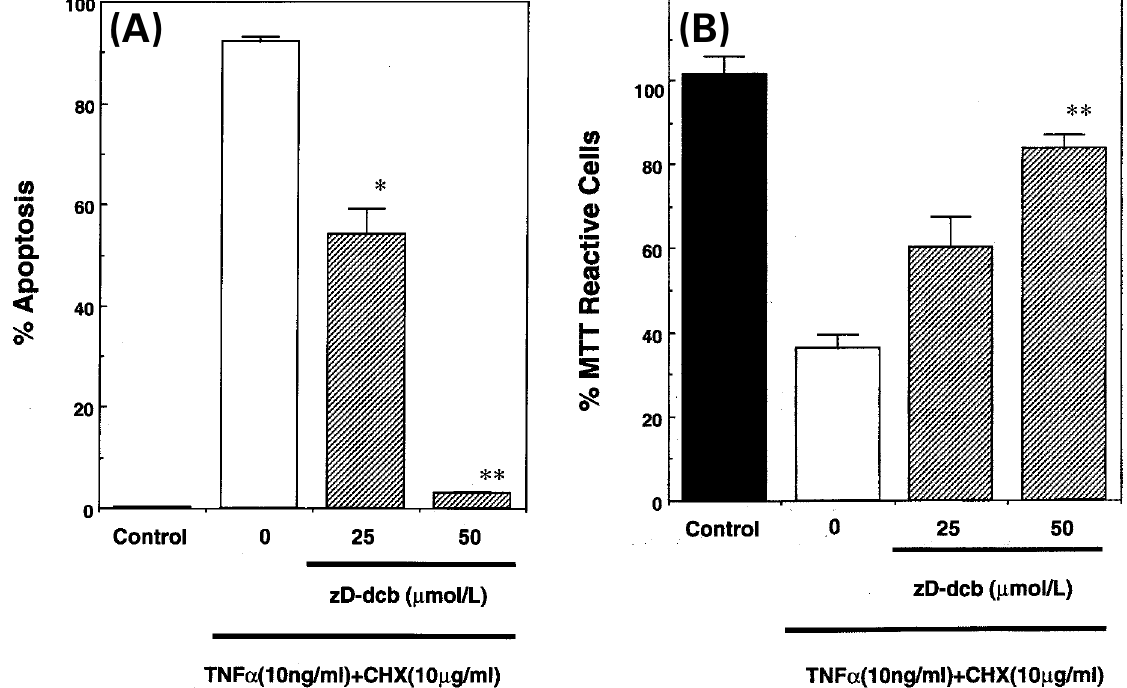
FIG. 4. Effect of an inhibitor of caspase on TNF a and cycloheximide-induced apoptosis of endothelial cells. (A) Endothelial cell monolayers were treated with TNF a (10ng/ml) and cycloheximide (10 m g/ml) in the presence of various concentration of zD- dcb, an inhibitor of ICE (0–50 m mol/l), for 6h. After the incubation treatment, the cells were stained with PI, as described in Materials and methods. * P <0.05 versus TNF a and cycloheximide-treated group; ** P <0.01 versus TNF a and cycloheximide- treated group. Each experiment was repeated three times. (B) Endothelial cell monolayers were treated with TNF a (10ng/ml) and cycloheximide (10 m g/ml) in the presence of various concentration of zD-dcb, an inhibitor of caspase (0–50 m mol/l), for 6h. After the incubation treatment, the cells were stained with MTT, as described in Materials and methods. The data show the mean±SEM for eight wells. ** P <0.01 versus TNF a and cycloheximide-treated group. Each experiment was repeated three